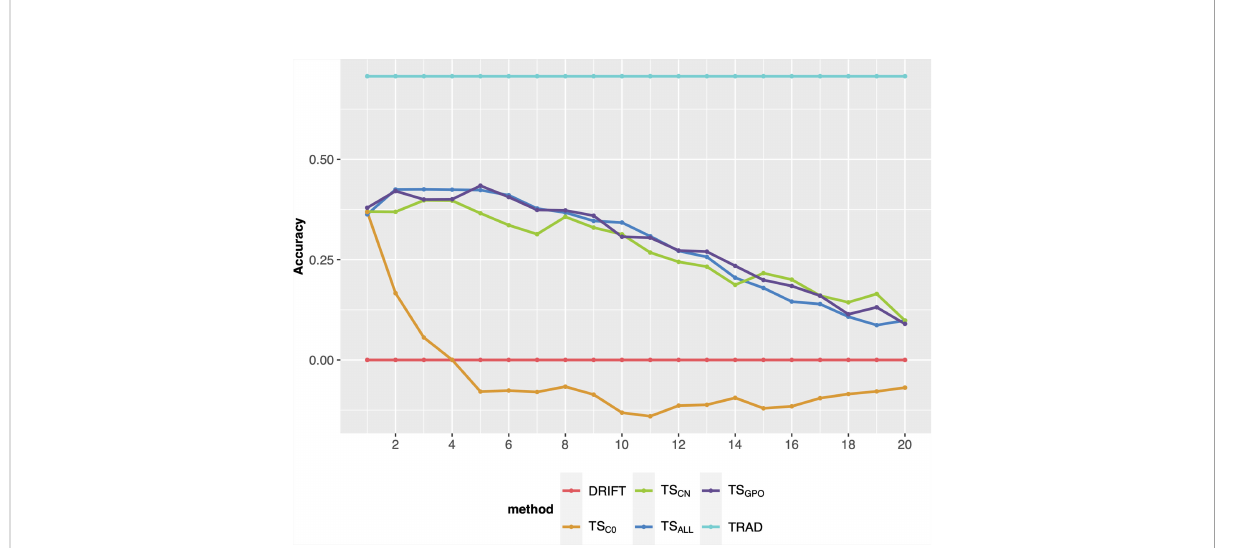
FIGURE 4 Prediction accuracy of selection over 20 breeding cycles via GS F2 S F4 scheme considering 48 parental lines using different methods to update the training set. Each colored line represents an updating training set method. TS C0 : training set without updates; TS CN : a new training set was built every cycle with the previous generation; TS ALL : training set updated every cycle with the addition of a new set from the previous cycle; TS GPO : training set built with the three last generations and updated each cycle.